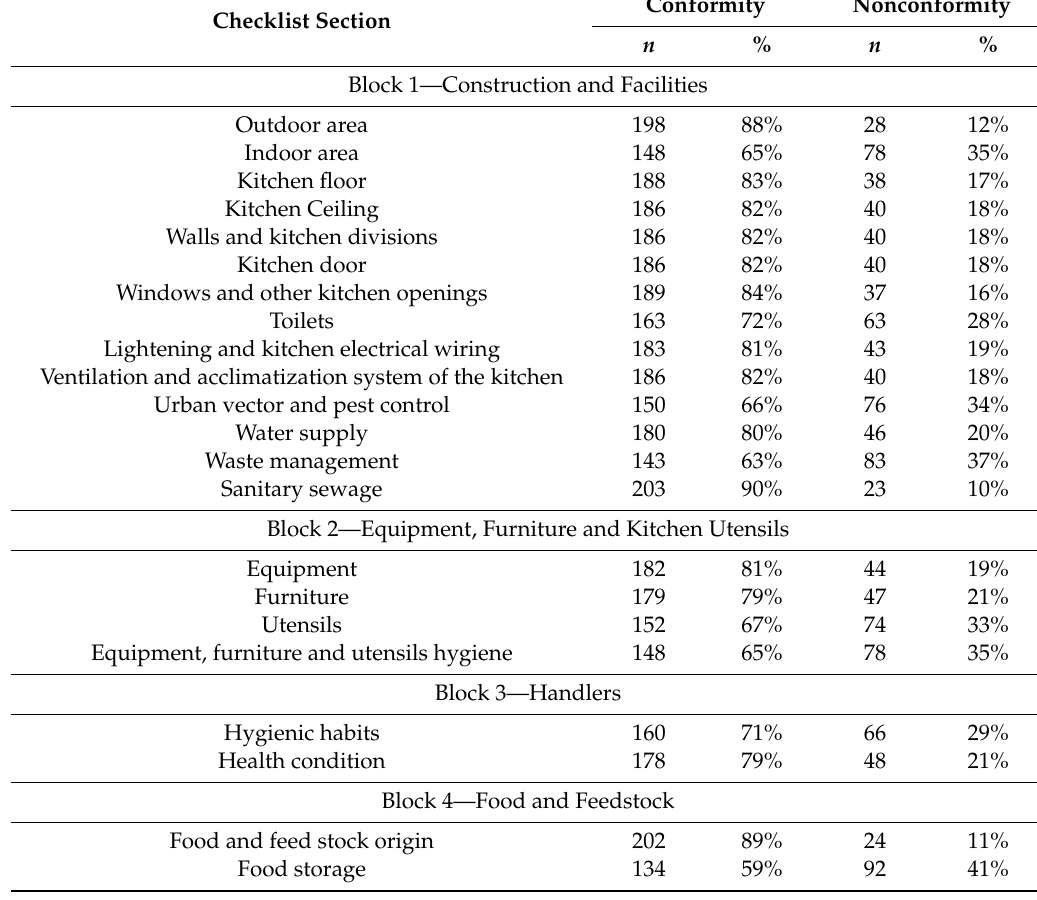
Table 2. Frequency of conformities and nonconformities in home kitchens in the Federal District / Brazil, 2019 ( n = 226).